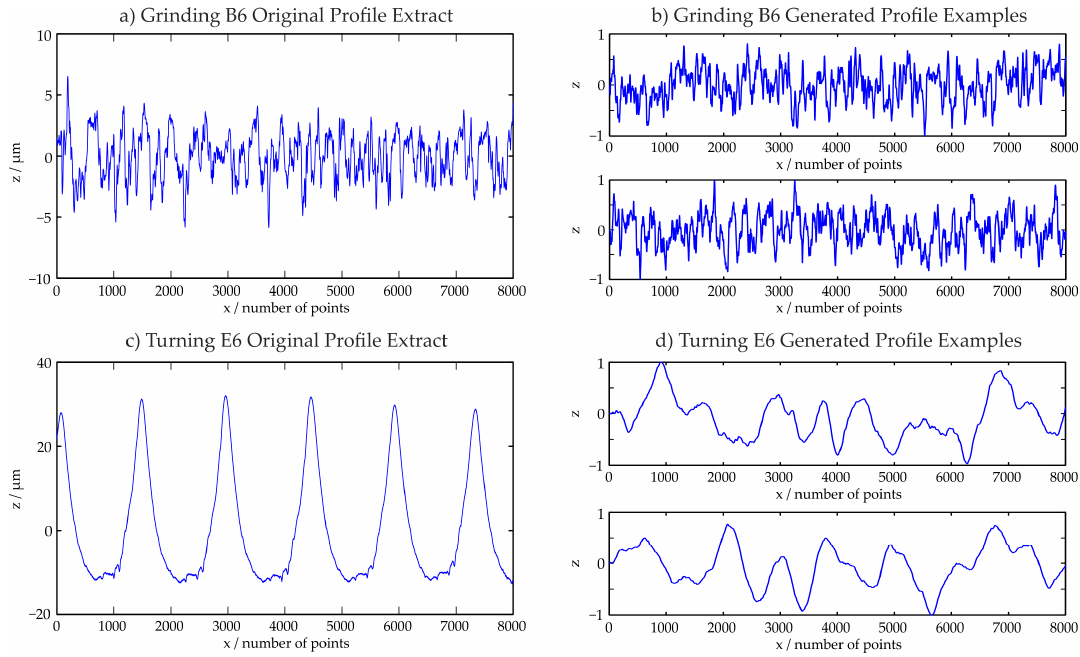
Figure 8. Examples for generated profiles for stochastic (Grinding B6) and deterministic (Turning E6) surfaces.